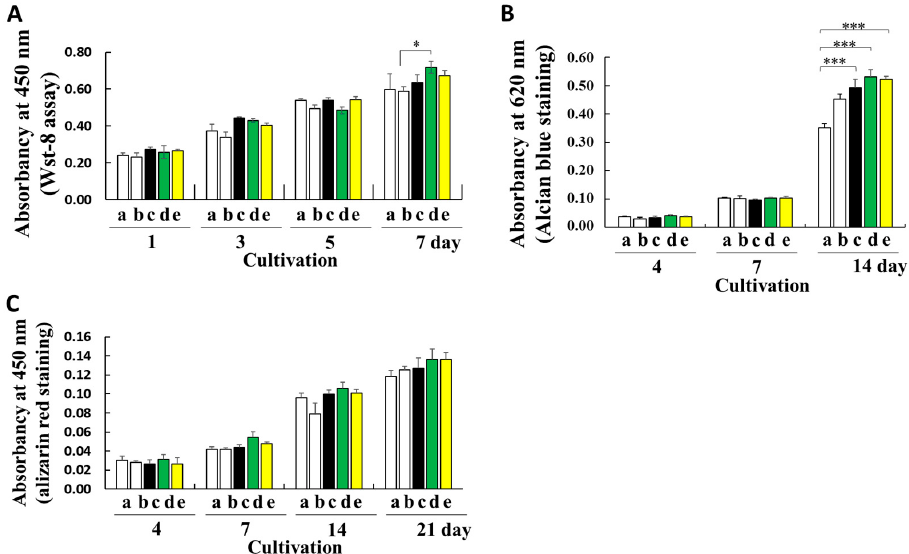
Figure 5. Cultivation of ATDC5 cells on fibroin biomaterials. ( A ) Comparison of cell viability on noncoated substrates (column a), gelatin-coated substrates (column b), and substrates coated with fibroin solutions prepared from degummed w1-pnd (column c), non-degummed Ser-P1A269 (column d), and Ser1/3-P1A269 (column e) cocoons by measuring the WST-8 reaction on the indicated day after cell seeding. Data are shown as the means ± SD; n = four independent samples; * p < 0.05 (one-way ANOVA, followed by Tukey’s test). ( B ) Early chondrogenic differentiation of ATDC5. The ATDC5 cells were cultured in a differentiation medium; on the indicated day, signs of early differentiation such as cartilage nodule formation were investigated by measuring the amount of glycosaminoglycan produced via Alcian blue staining. Data are shown as the means ± SD; n = four independent samples; *** p < 0.001 (one-way ANOVA, followed by Tukey’s test). ( C ) Late osteogenic differentiation of ATDC5 cells. During the late osteogenic differentiation of ATDC5, the mineralization of the extracellular matrix was assessed by alizarin red staining. Data are shown as the means ± SD; n = four independent samples (not significant by one-way ANOVA with Tukey’s